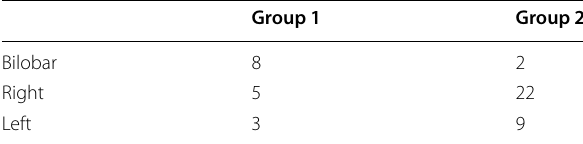
Table 2 Anatomical site at presentation of malignant and non-